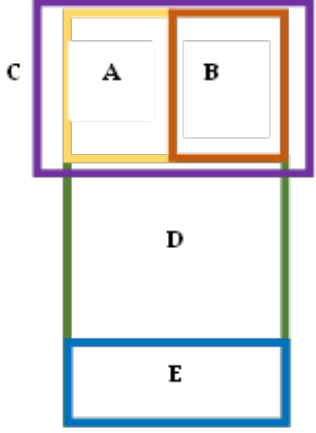
Figure 4. Display the principle of the HMI.